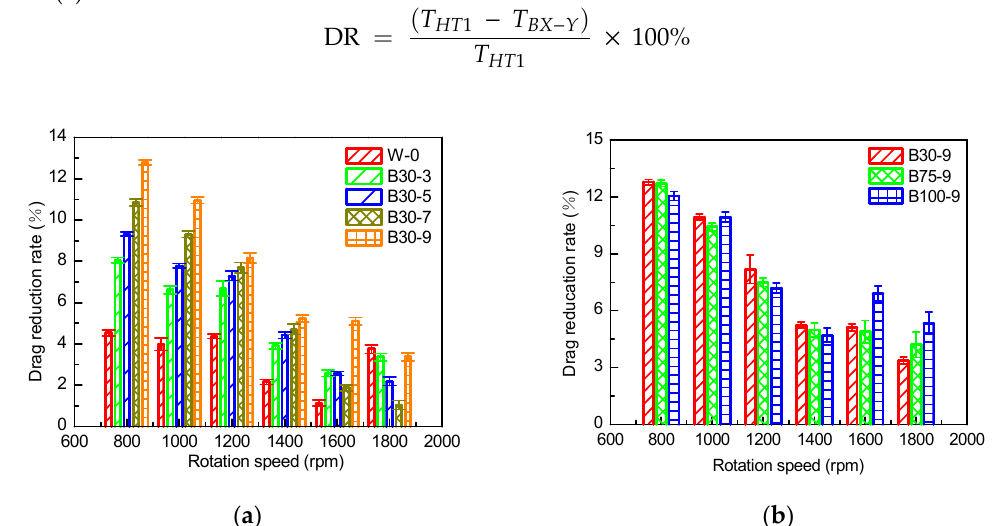
Figure 8. The influence of the additive ( a ) and viscosity ( b ) of PSO on drag reduction rate.